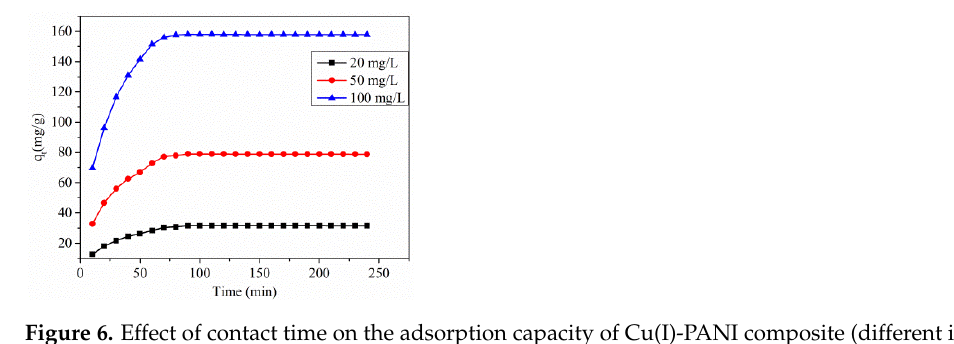
Table 1. Isotherm parameters for the adsorption of RO16 dye onto Cu(I)-PANI composite. Langmuir Isotherm